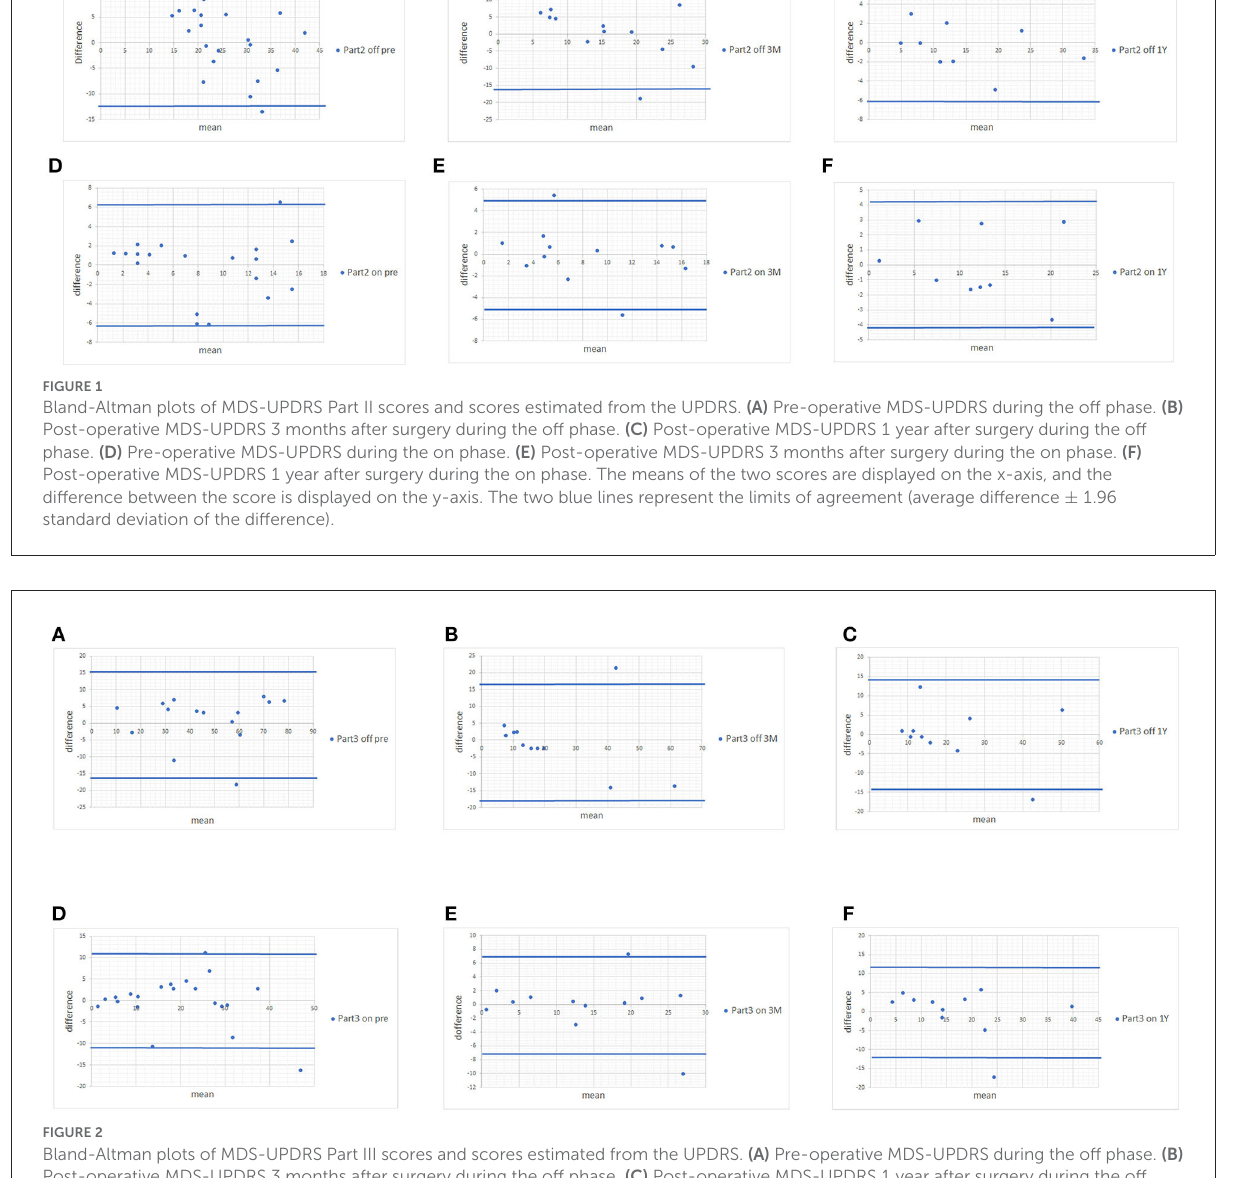
indicate a high dropout rate in this study. The small